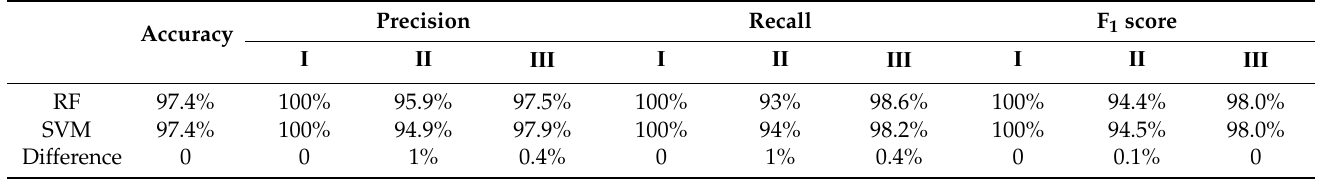
Table 5. RF and SVM optimization model evaluation indexes for the test samples.